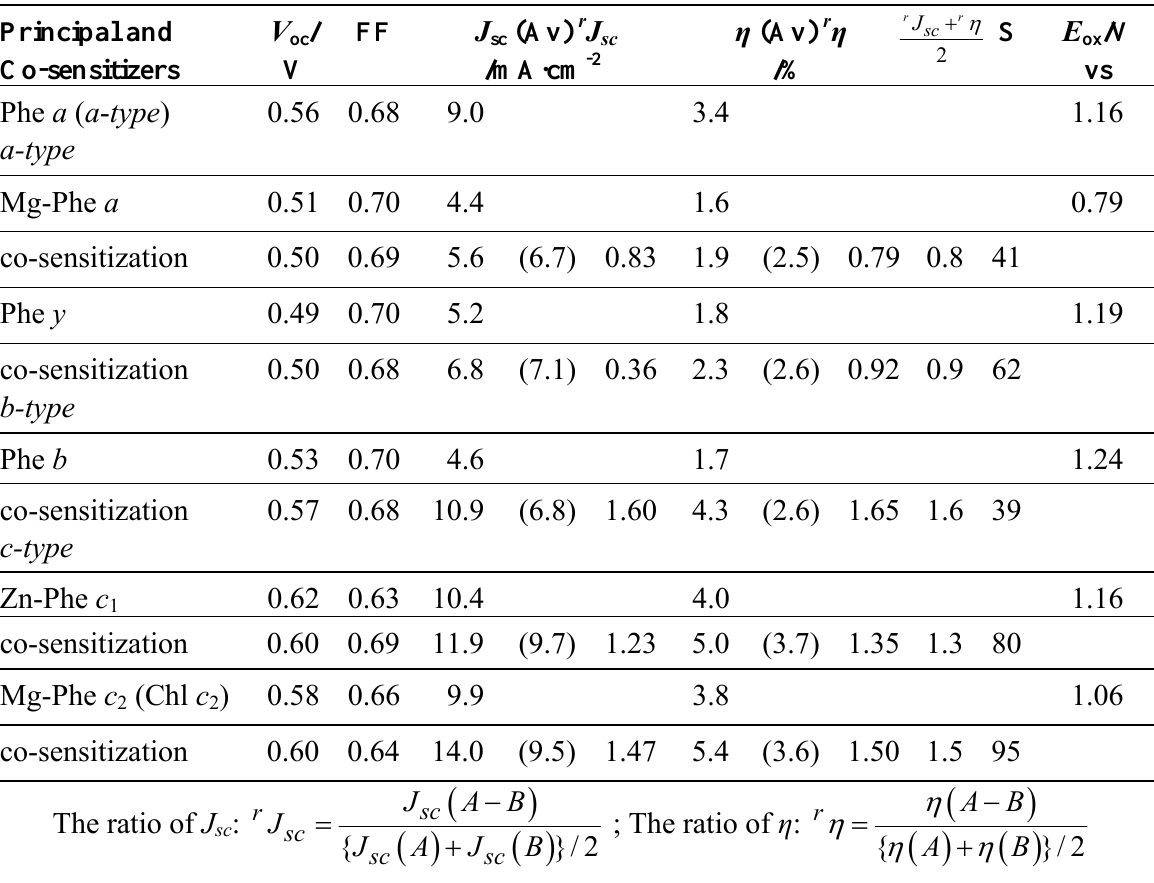
), fill factor ( FF ), short-circuit photo-current oc ) of the sensitizers. ox